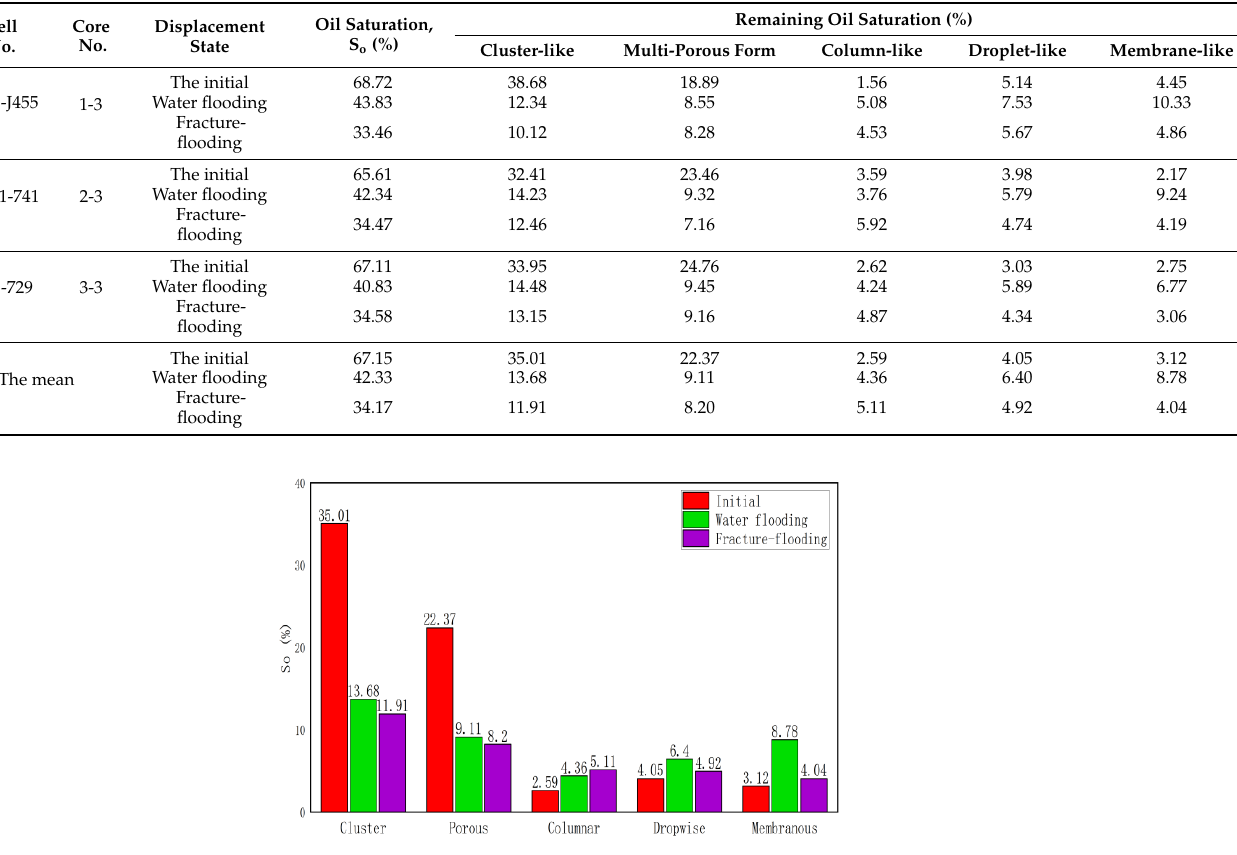
Figure 15. Three-dimensional distribution map of remaining oil constructed after CT scan. Table 6. Data table of microscopic remaining oil distribution content after CT scan. Remaining Oil Saturation (%) Oil 18 of 20 Well Core Displacement Saturation, Multi- Cluster- Column- Droplet- Membrane- No. No. State S o Porous like like like like (%) Form